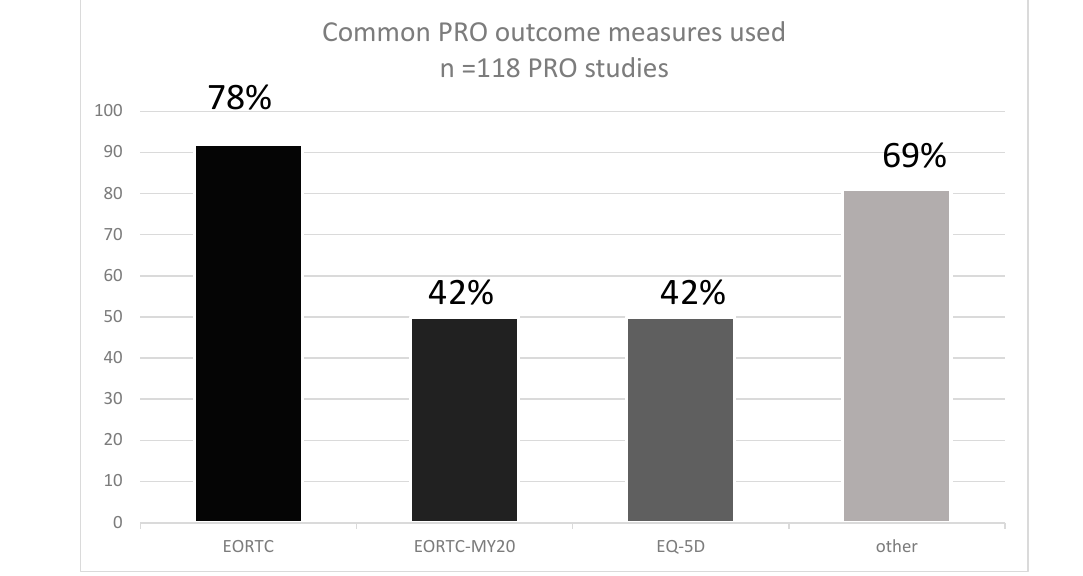
Figure 2. The prevalence of PRO instruments used in MM RCTs according to the SLR. Of 283 studies, 40% included subjects on first-line treatment, 42% on 2nd line treat- ment, and others were evaluating both or unknown. For less than half of the studies, a protocol was found. In 39 studies for which a study protocol was found, only 19 reported PRO instruments consistently with the trial registry for the study. In addition, HTA re-